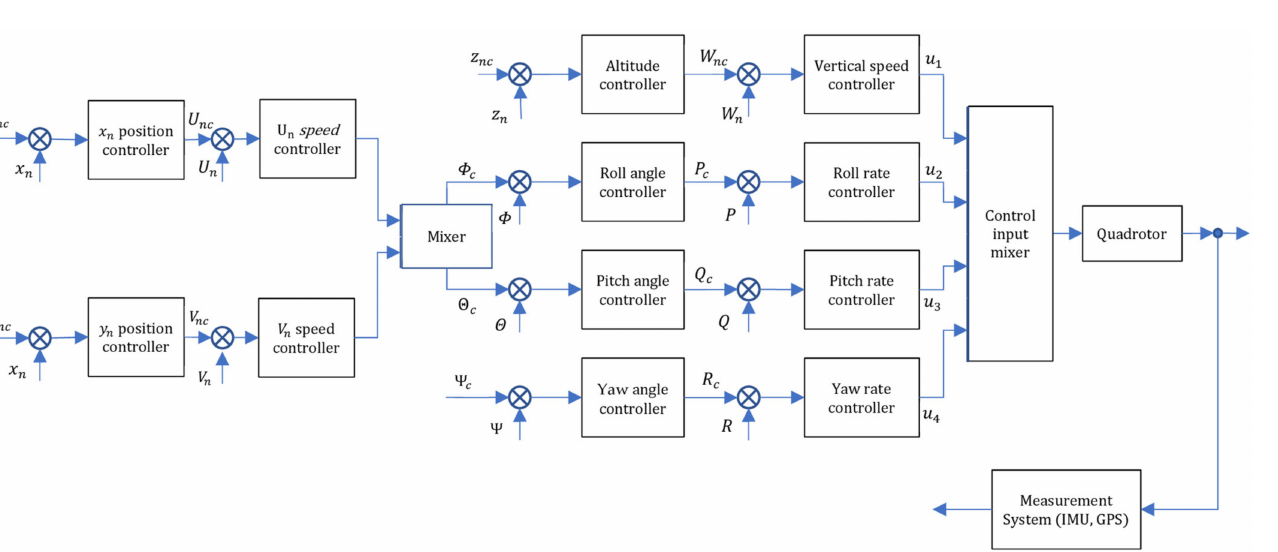
Figure 7. Automatic flight control system